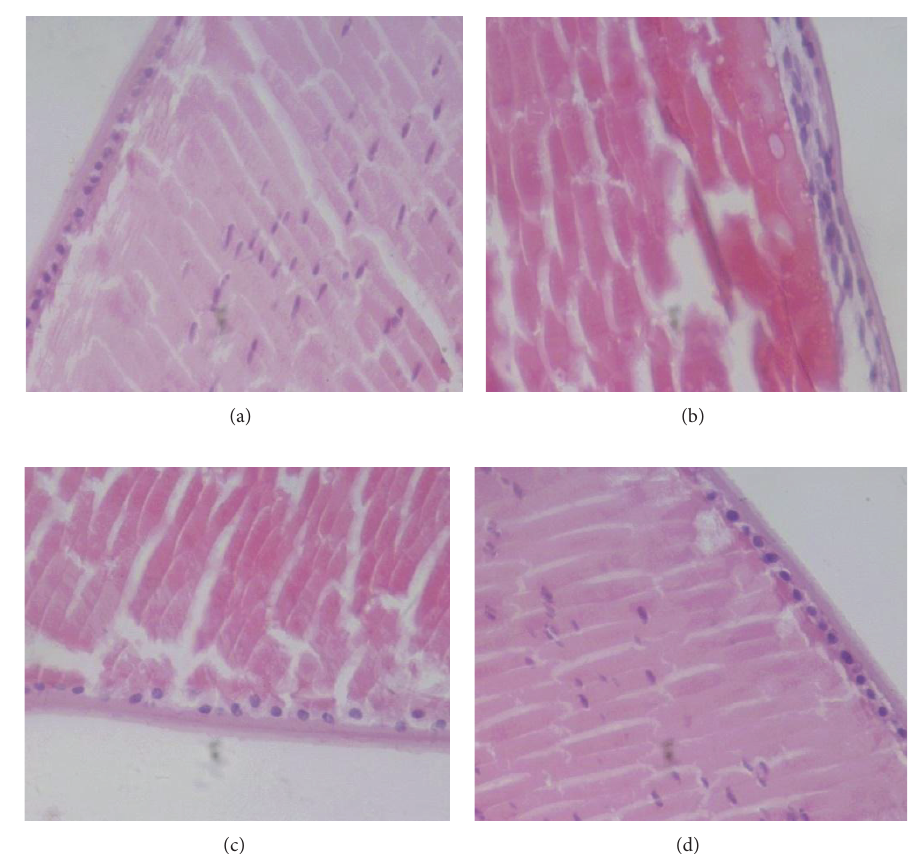
Figure 3: Histological examination of lenses of cataractous rats after 72 hours treatment with rHV3 eye drops. (a): normal control (group A); (b): diabetic cataracts untreated (group B); (c) and (d): diabetic cataracts treated with 50 𝜇 L (one drop) of 0.5, 2ATU/ 𝜇 L rHV3 eye drops,